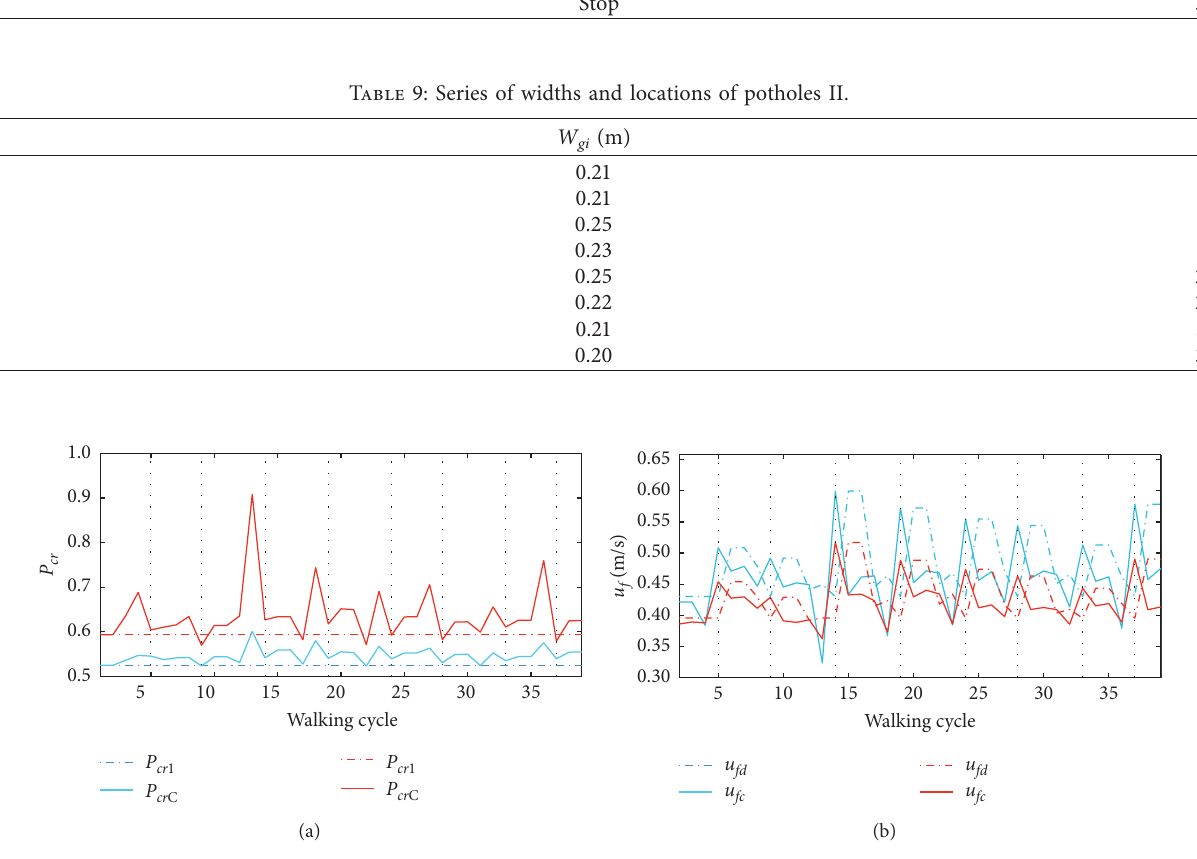
Figure 6: Walking on the discontinuous compliant ground. (a) The relative position changes of the robot CoM. (b) The horizontal velocity changes of the robot